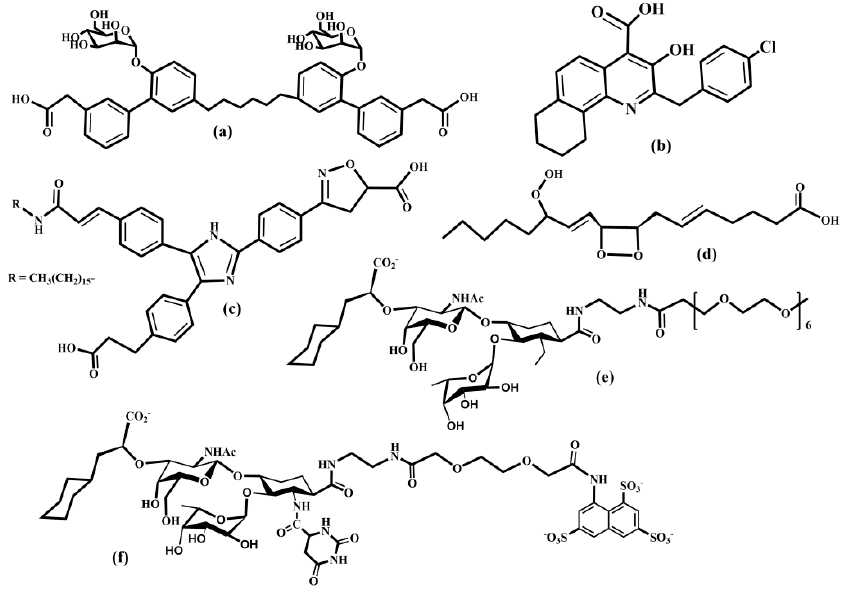
Figure 15. Selectin inhibitors in preclinical and clinical trials: ( a ) Bimosiamose, ( b ) PSI-697, ( c ) Figure15. Selectininhibitorsinpreclinicalandclinicaltrials: ( a )Bimosiamose, ( b )PSI-697, ( c )OC-229648, OC-229648, ( d ) PGX200, ( e ) uproleselan, and (f) rivipansel. ( d ) PGX200, ( e ) uproleselan, and ( f )